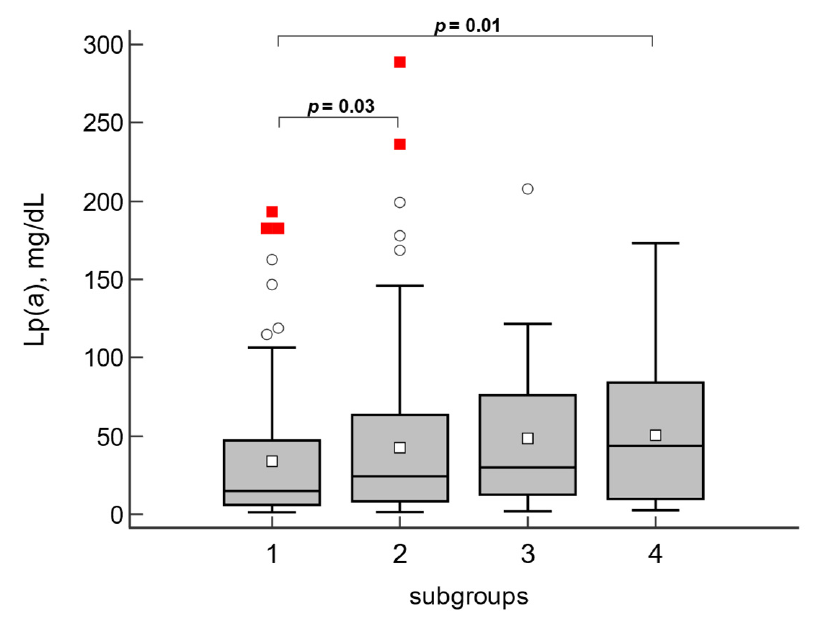
concentration of Lp(a), HDL—high-density lipoprotein cholesterol, Lp(a)—lipoprotein(a). When comparing Lp(a) levels of patients divided into four groups according to the combination of different atherosclerotic lesion phenotypes (segmental without calcinosis, diffuse without calcinosis, segmental with calcinosis, and diffuse with calcinosis), the highest level was observed in the most severe type (diffuse lesions with CA calcinosis) (Figure 1).